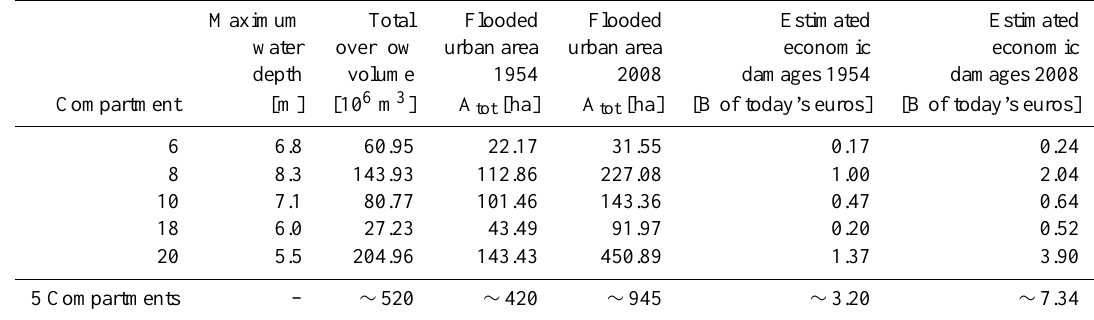
Table 1. Reference inundation scenario: flooded C-Buffer compartments according to the quasi-2-D model (see Castellarin et al., 2011a and Fig. 2). Maximum Total Flooded Flooded Estimated Estimated water overflow urban area urban area economic economic depth volume 1954 2008 damages 1954 damages 2008 Compartment